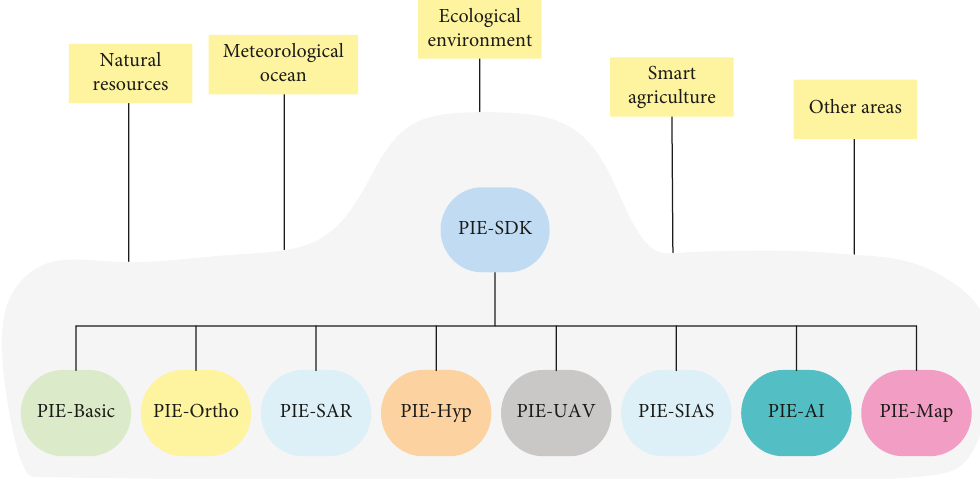
Figure 6: PIE 6.0 remote sensing technology and its application system